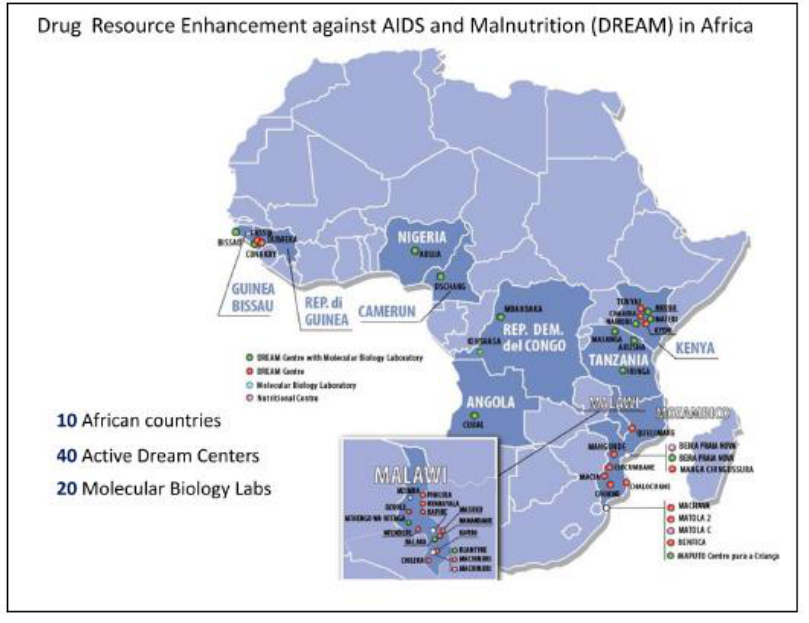
Figure 1. DREAM centers in Sub-Saharan